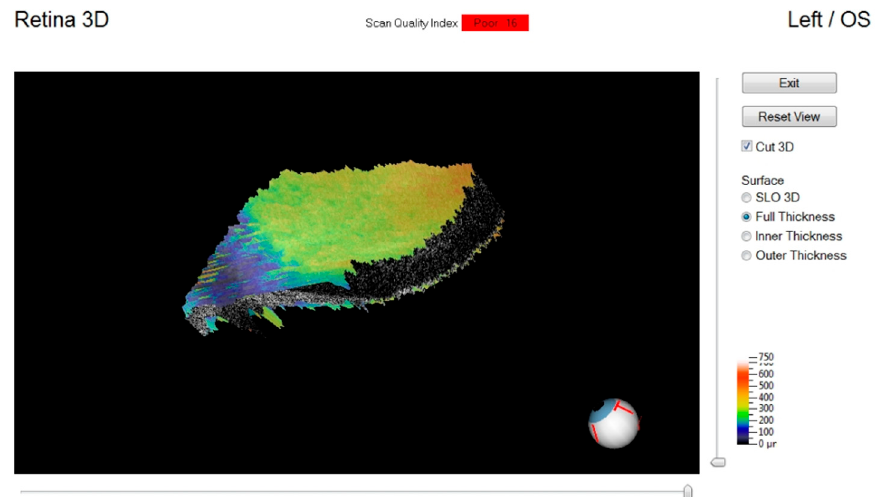
Figure 6. Retinal ( A ) full map and foveal scan at 6th hour ( B ). There is an appreciable separation between the inner and outer layers and early degeneration of nervous tissue. The device permits a pachymetric observation of the tissue and a 3D view of the surface (Figure 7).